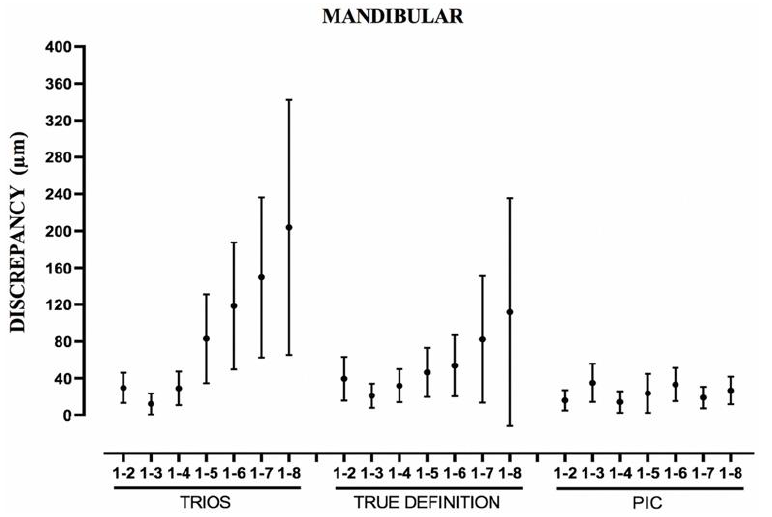
Figure 5. Boxplot showing measurements of Euclidean distances from distance 1 - 2 to 1 - 8 of man- dibular arch. Point represents mean error; line represents standard deviation.